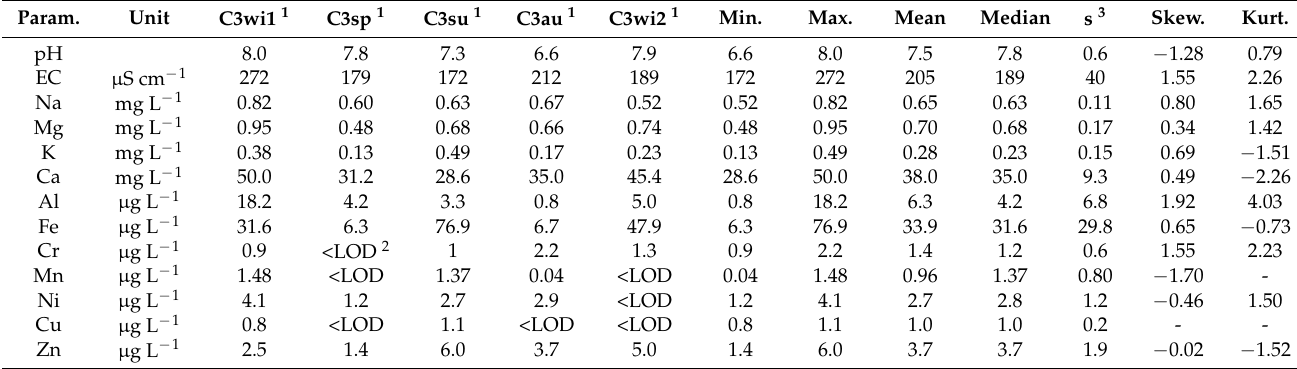
Table 2. Hydrogeochemical characteristics and summary statistics of the water samples seasonally collected from C3.